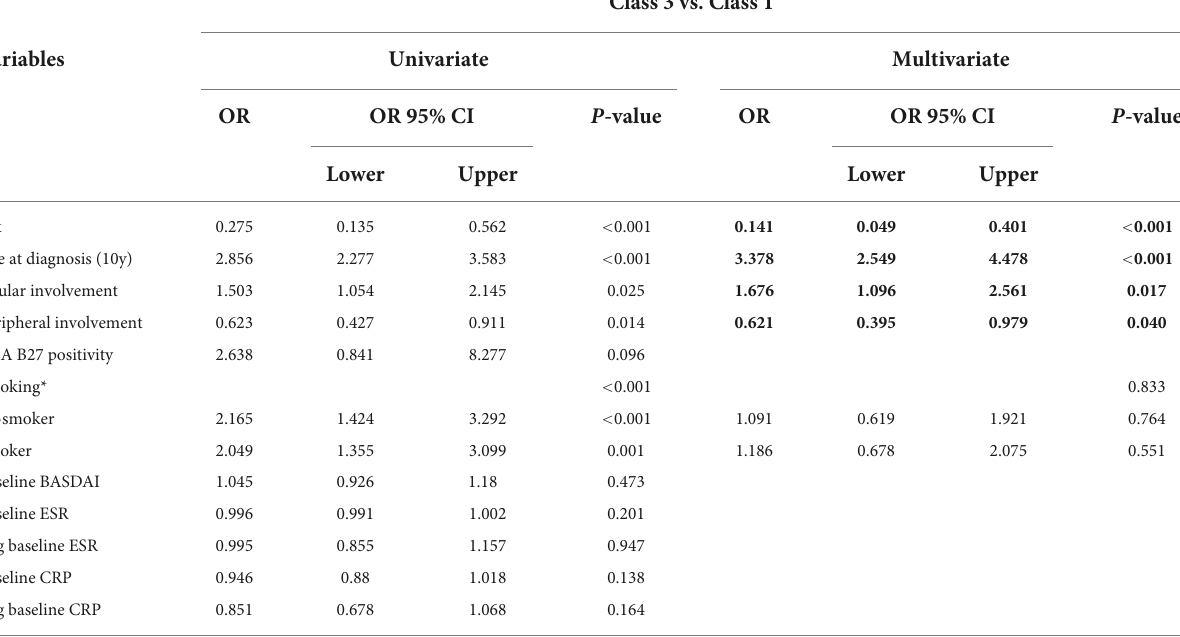
TABLE 4 Multivariate logistic regression analysis of mSASSS progression for associated factors in class 3 and class 1 according to disease